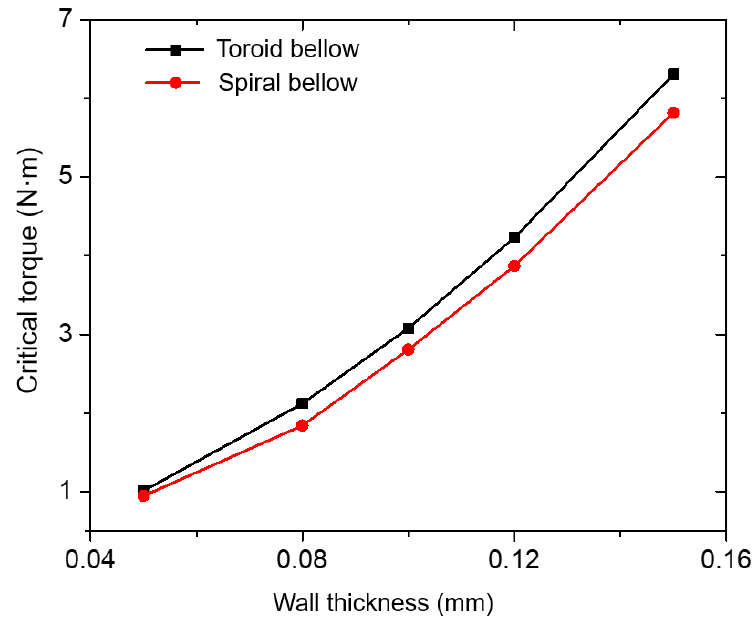
Figure 14. Curve of critical torque with wall thickness.